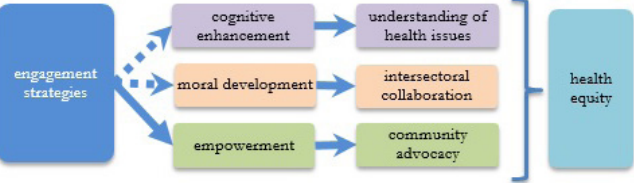
Figure 4: Democracy is realized through new pathways between participation and